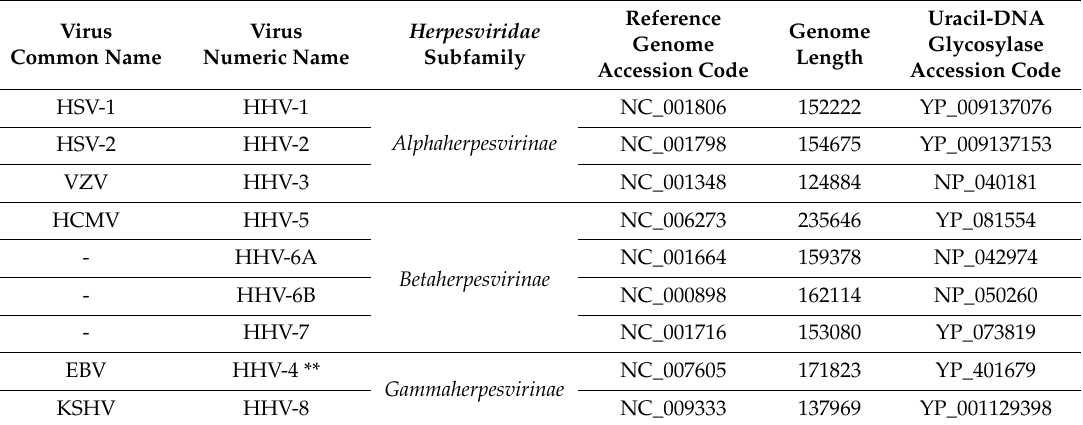
Table 1. Pathogenic herpesviruses of humans